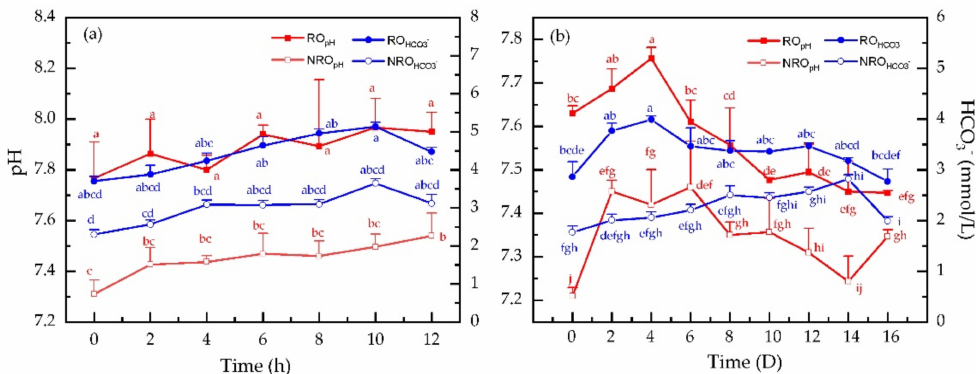
Figure 5. Diurnal and day-to-day variations in soil HCO 3 − and pH in two habitats. ( a ) Diurnal variation of soil HCO 3 − and pH under drought conditions. ( b ) Day-to-day variation of soil HCO 3 − and pH under drought conditions. RO and NRO represent the rock outcrop habitat and the non- outcrop habitat, respectively. Small letters indicate significant differences at 5% level p < 0.05